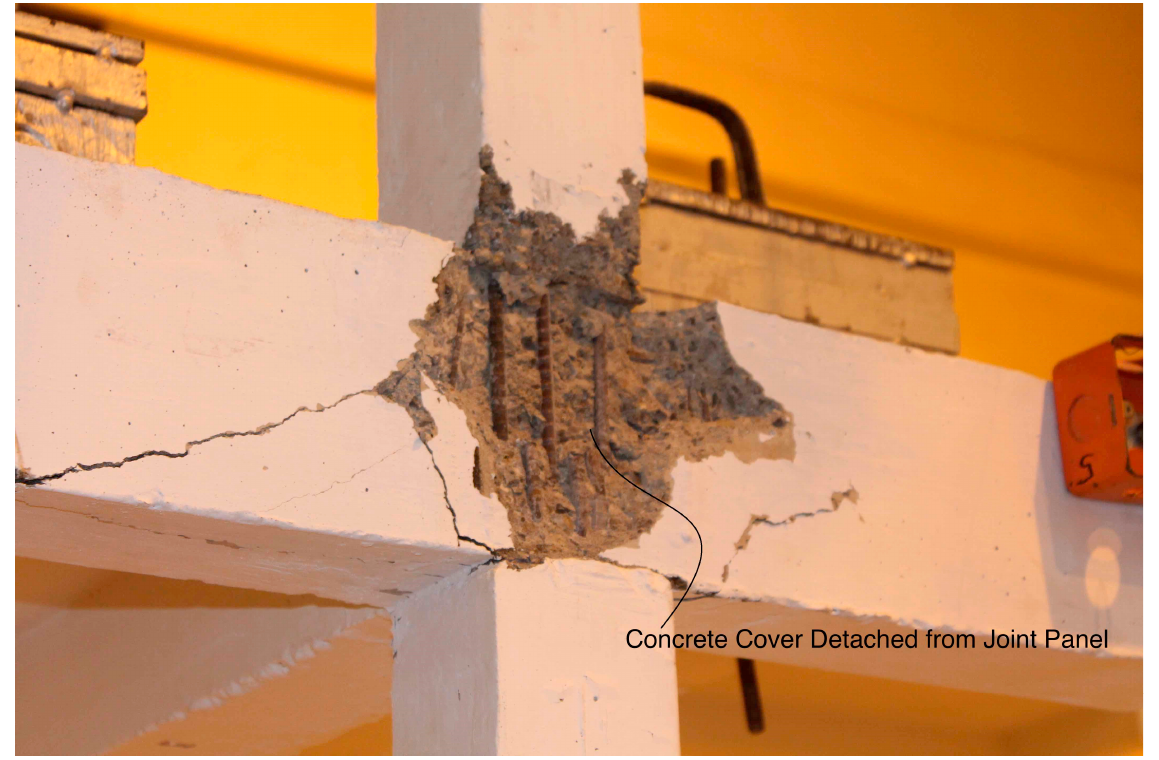
Figure 11. Extensive damage occurred at beam–column joint panel under test run 4 (ref. Table